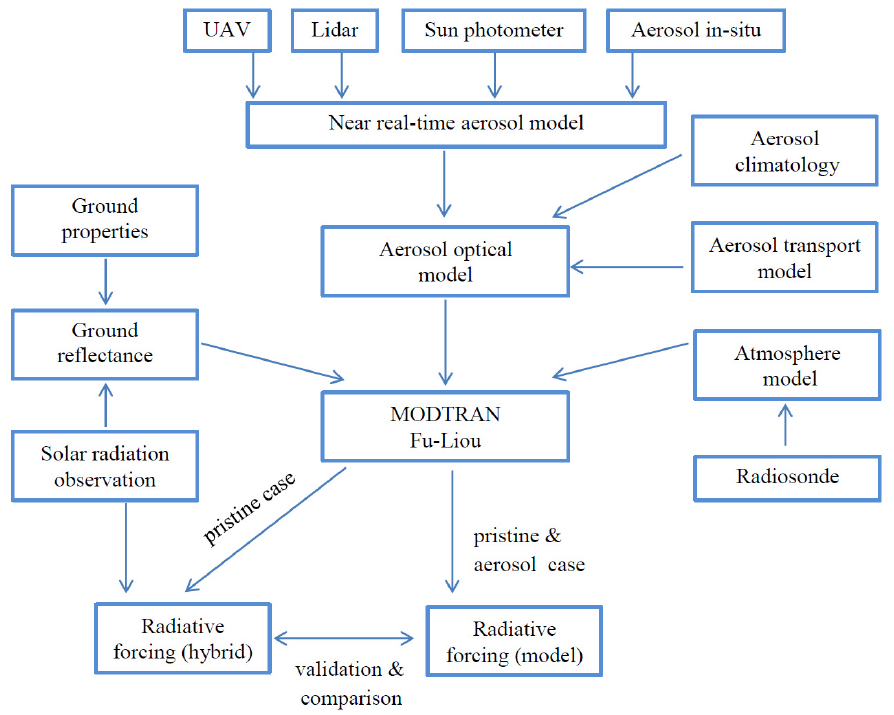
Figure 3. Diagram of the RTM interface with the Poland-AOD database.